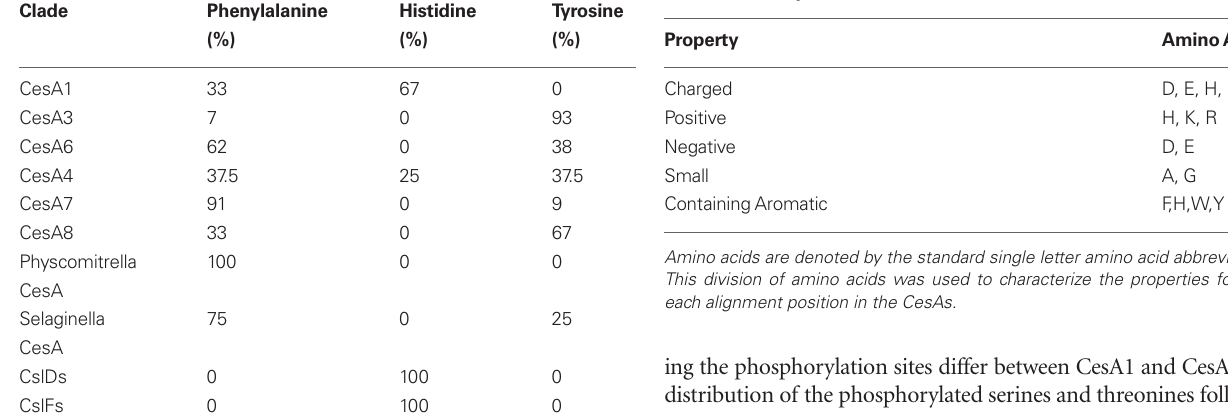
Table 8 | Amino acid properties probed for conservation of property without identity.